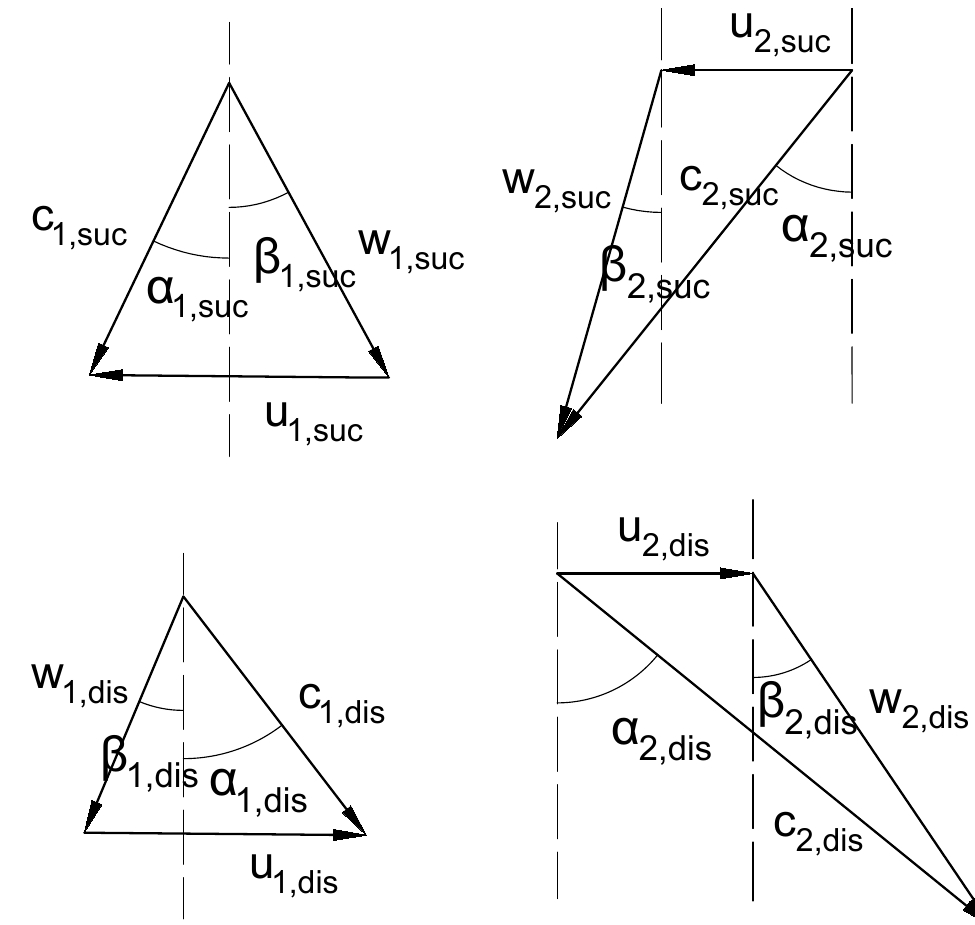
Figure 9. Velocity triangles in the two stages of a cross-flow fan using the cascade